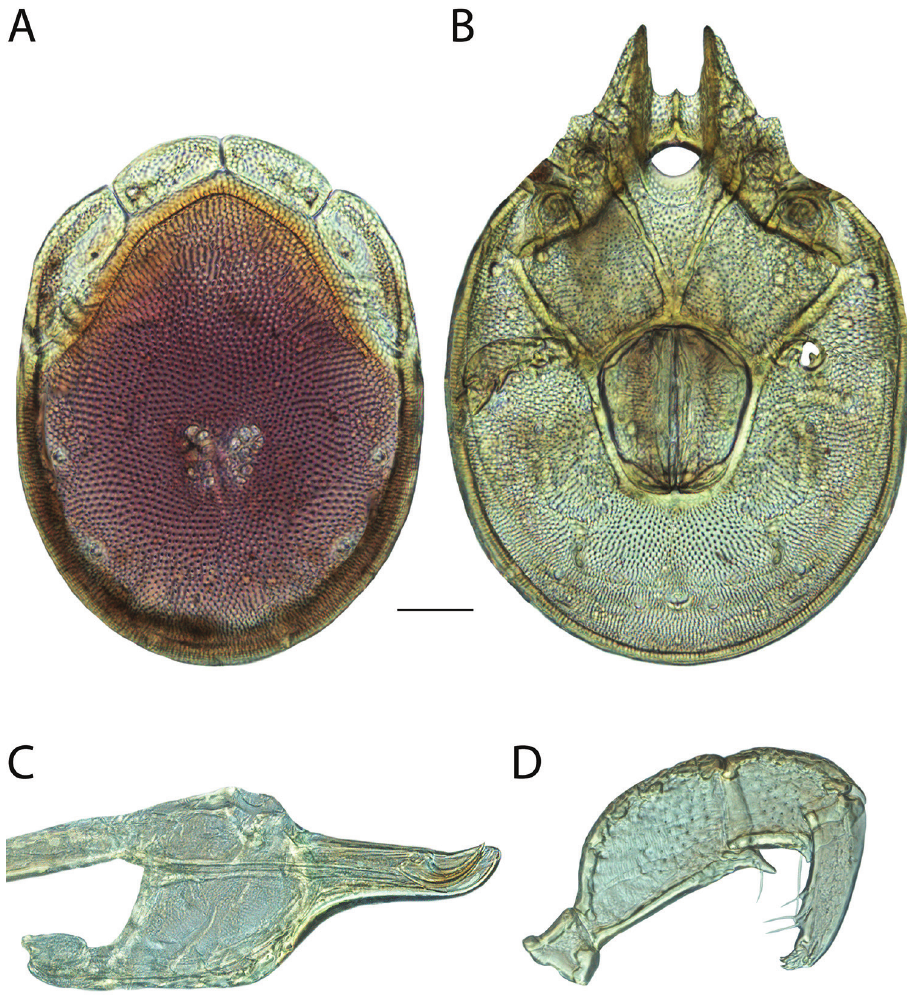
Figure 221. Torrenticola regalis sp. n. female: A dorsal plates B venter (legs removed) C subcapitulum D pedipalp (setae not accurately depicted). Scale = 100 µm.